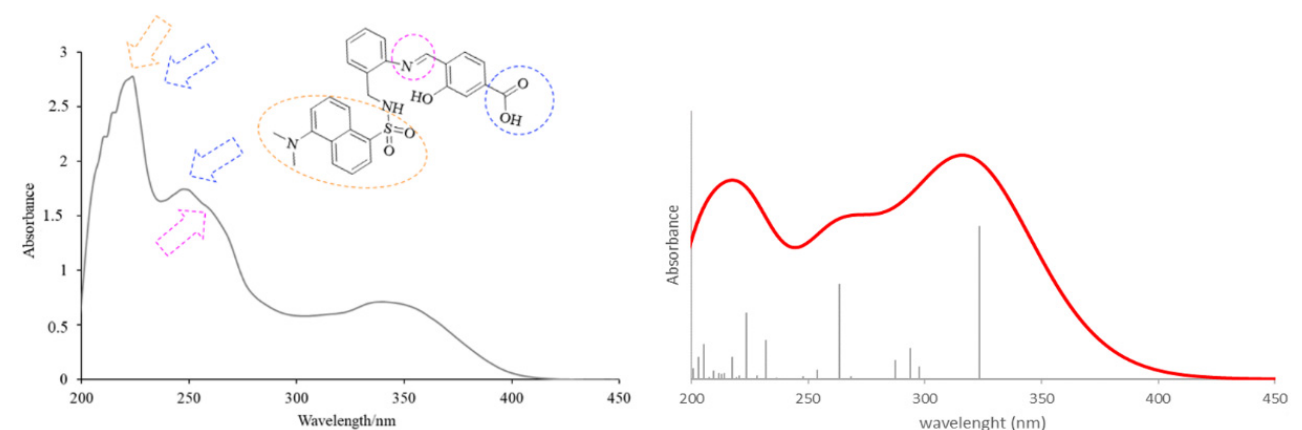
Figure 4. Experimental ( left ) and theoretical ( right ) profiles for the electronic spectrum of H 3 L. The signal assignment of the main groups of the molecule has been included as a scheme. The orange arrow shows the bands associated with the dansyl moiety. The blue arrows show the band associated with the carboxylic group and the pink arrow shows the band associated with the azomethine group. Vertical lines indicate individual electronic transitions listed in Table 1.